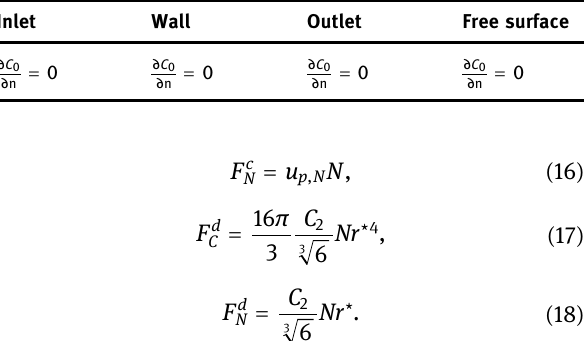
Table 2: Boundary condition for tracer transport